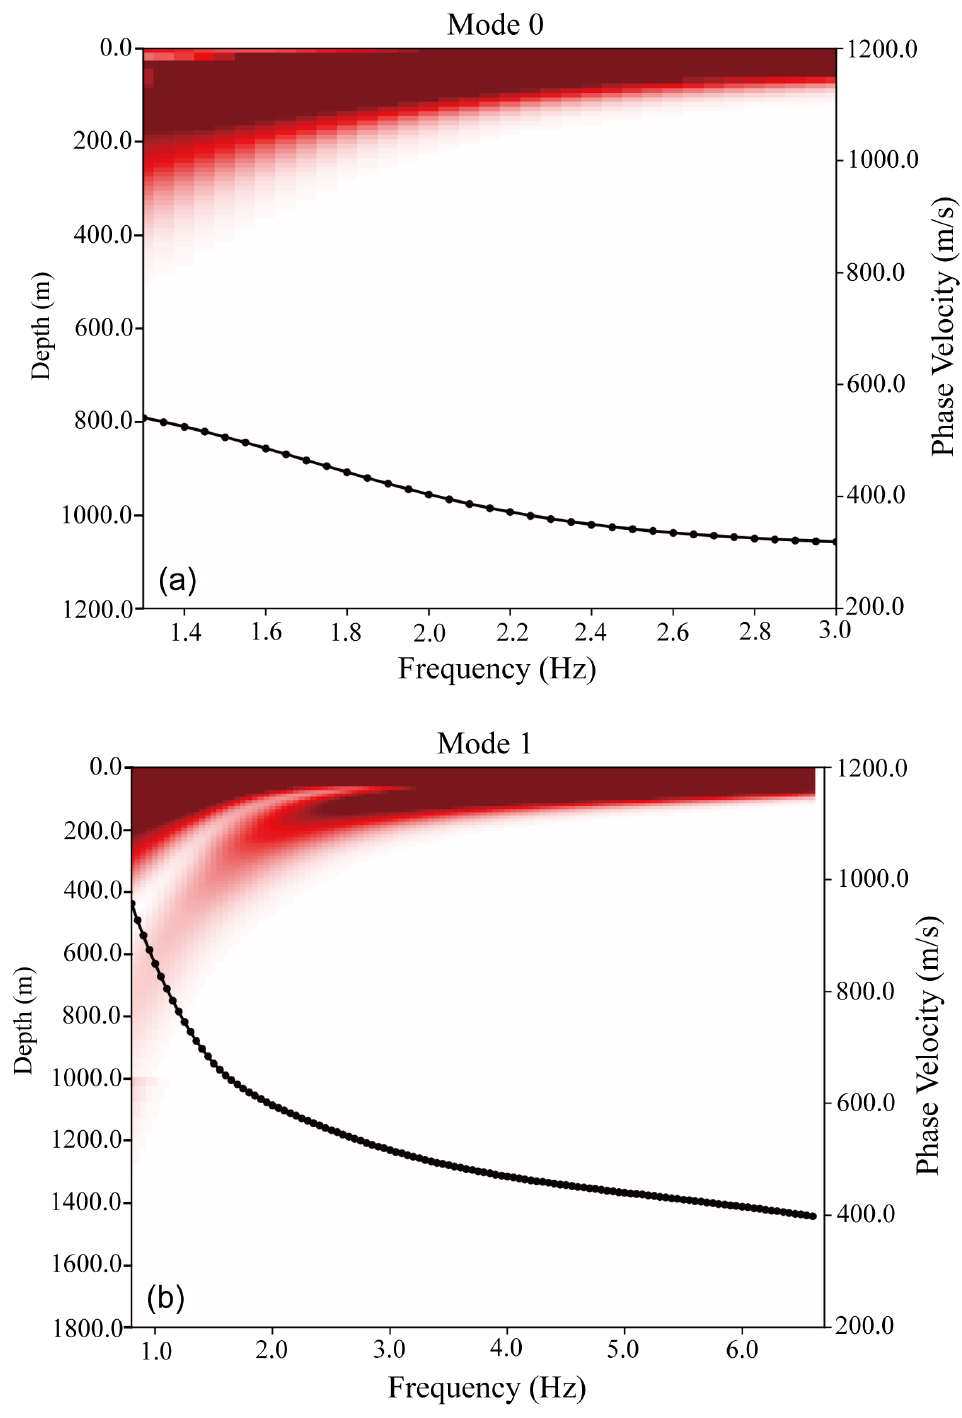
Figure 6. Sensitivity kernel of multi-mode dispersion curves. Only the frequency band used for inversion is shown. ( a ) Phase velocity dispersion curve and phase velocity sensitivity of the funda- mental mode (mode 0) in inversion showing the phase velocity dispersion curves (black dotted lines) of different modes under the inversion model and the dimensionless sensitivity kernel (marked in red) of the phase velocity relative to the S-wave velocity as a function of the frequency of the depth kernel. ( b ) Phase velocity dispersion curve and phase velocity sensitivity of the first higher-order mode (mode